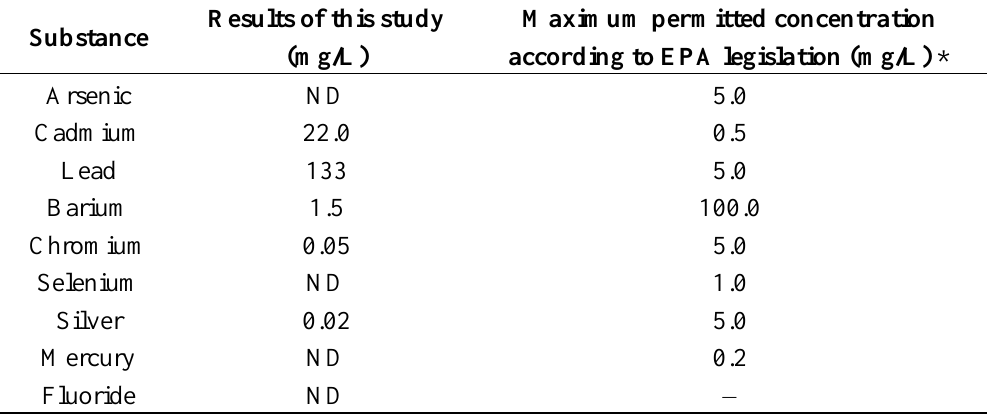
Table 2. Chemical analysis of leachate from milled